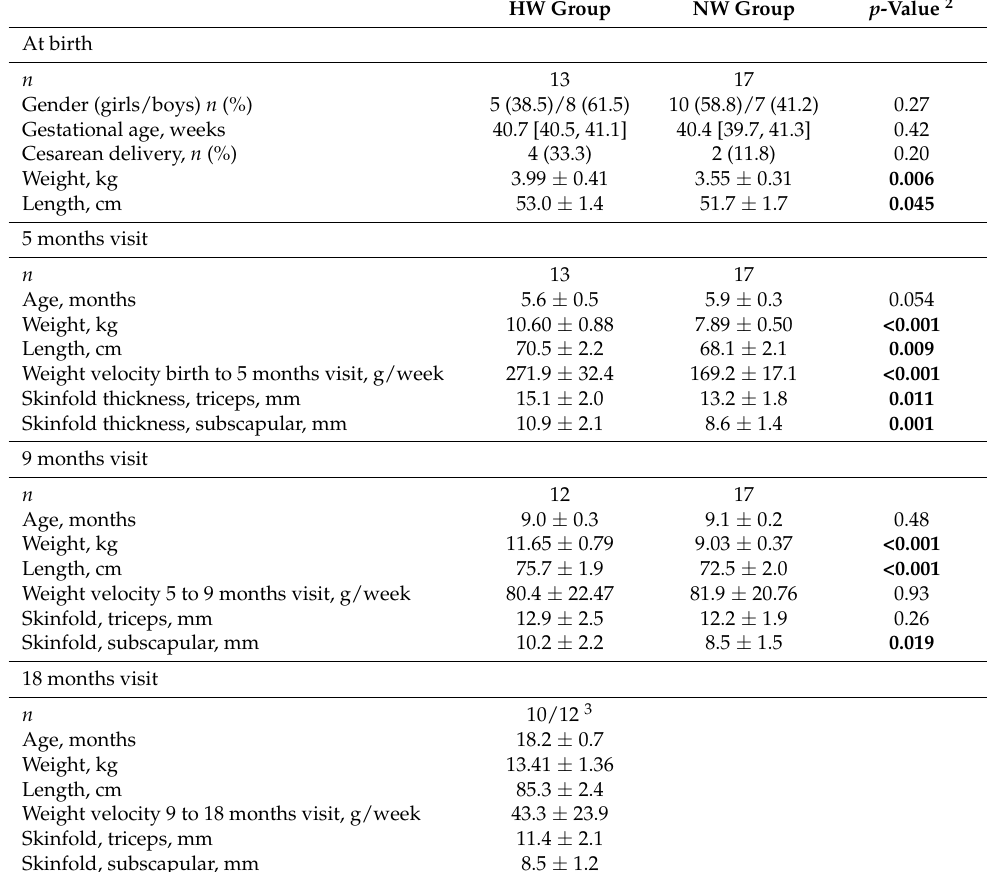
Table 1. Infant anthropometry according to the high weight gain and normal weight gain group 1 . HW Group NW Group p -Value